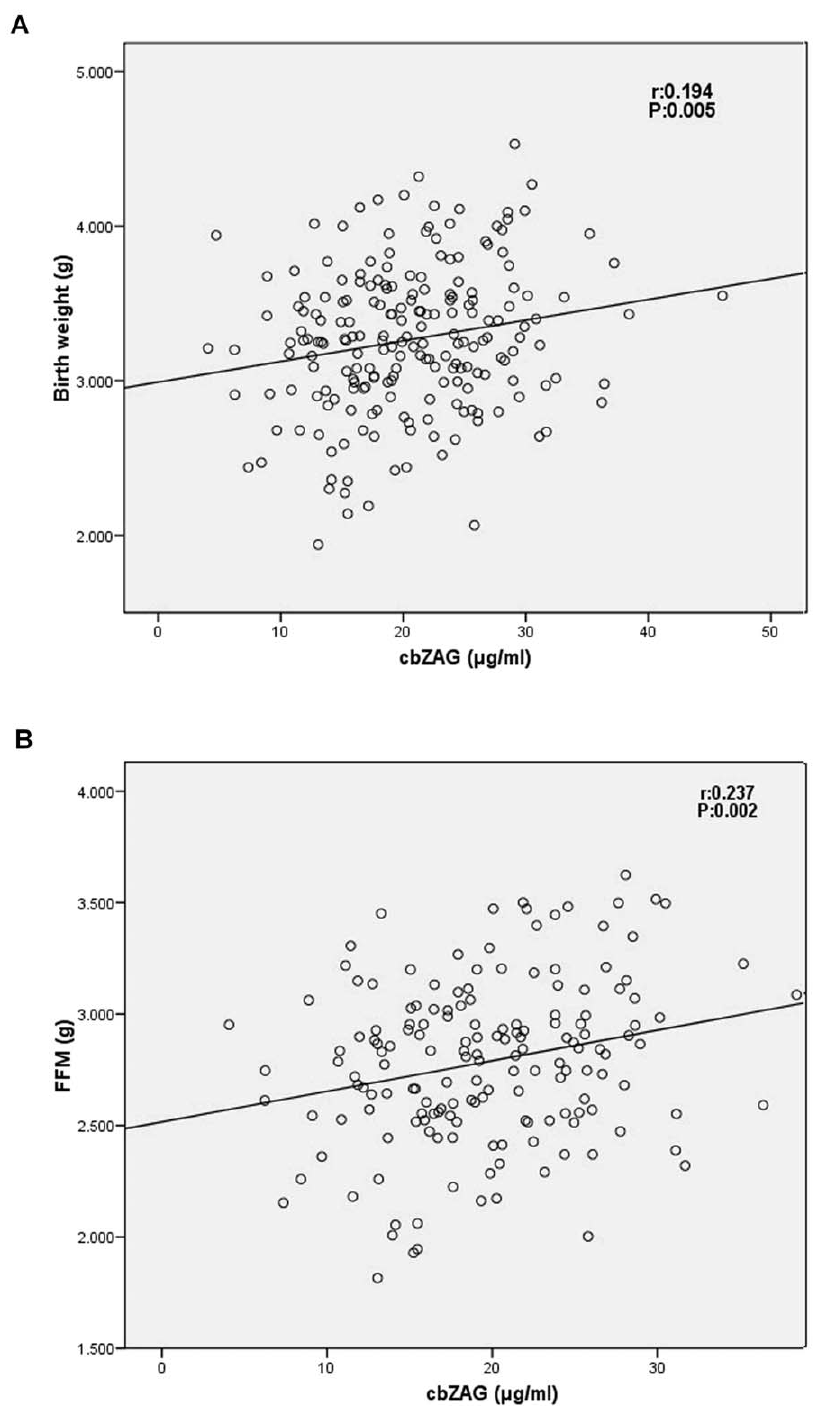
Figure 3. Correlation between serum cbZAG levels and anthropometric variables: birth weight (A) and fat-free mass (FFM) (B).